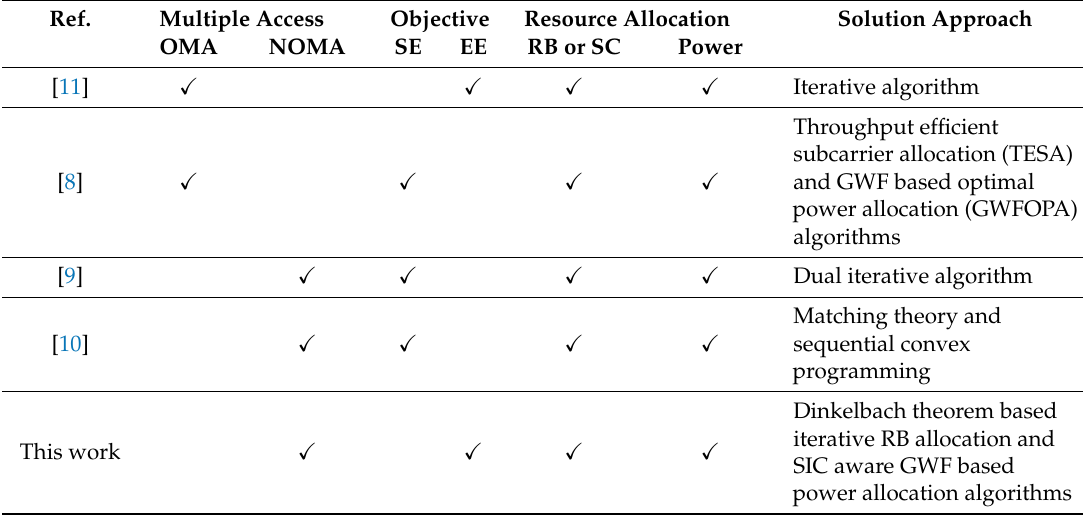
Table 1. Summary of resource optimization problems in cellular device-to-device (D2D) networks.